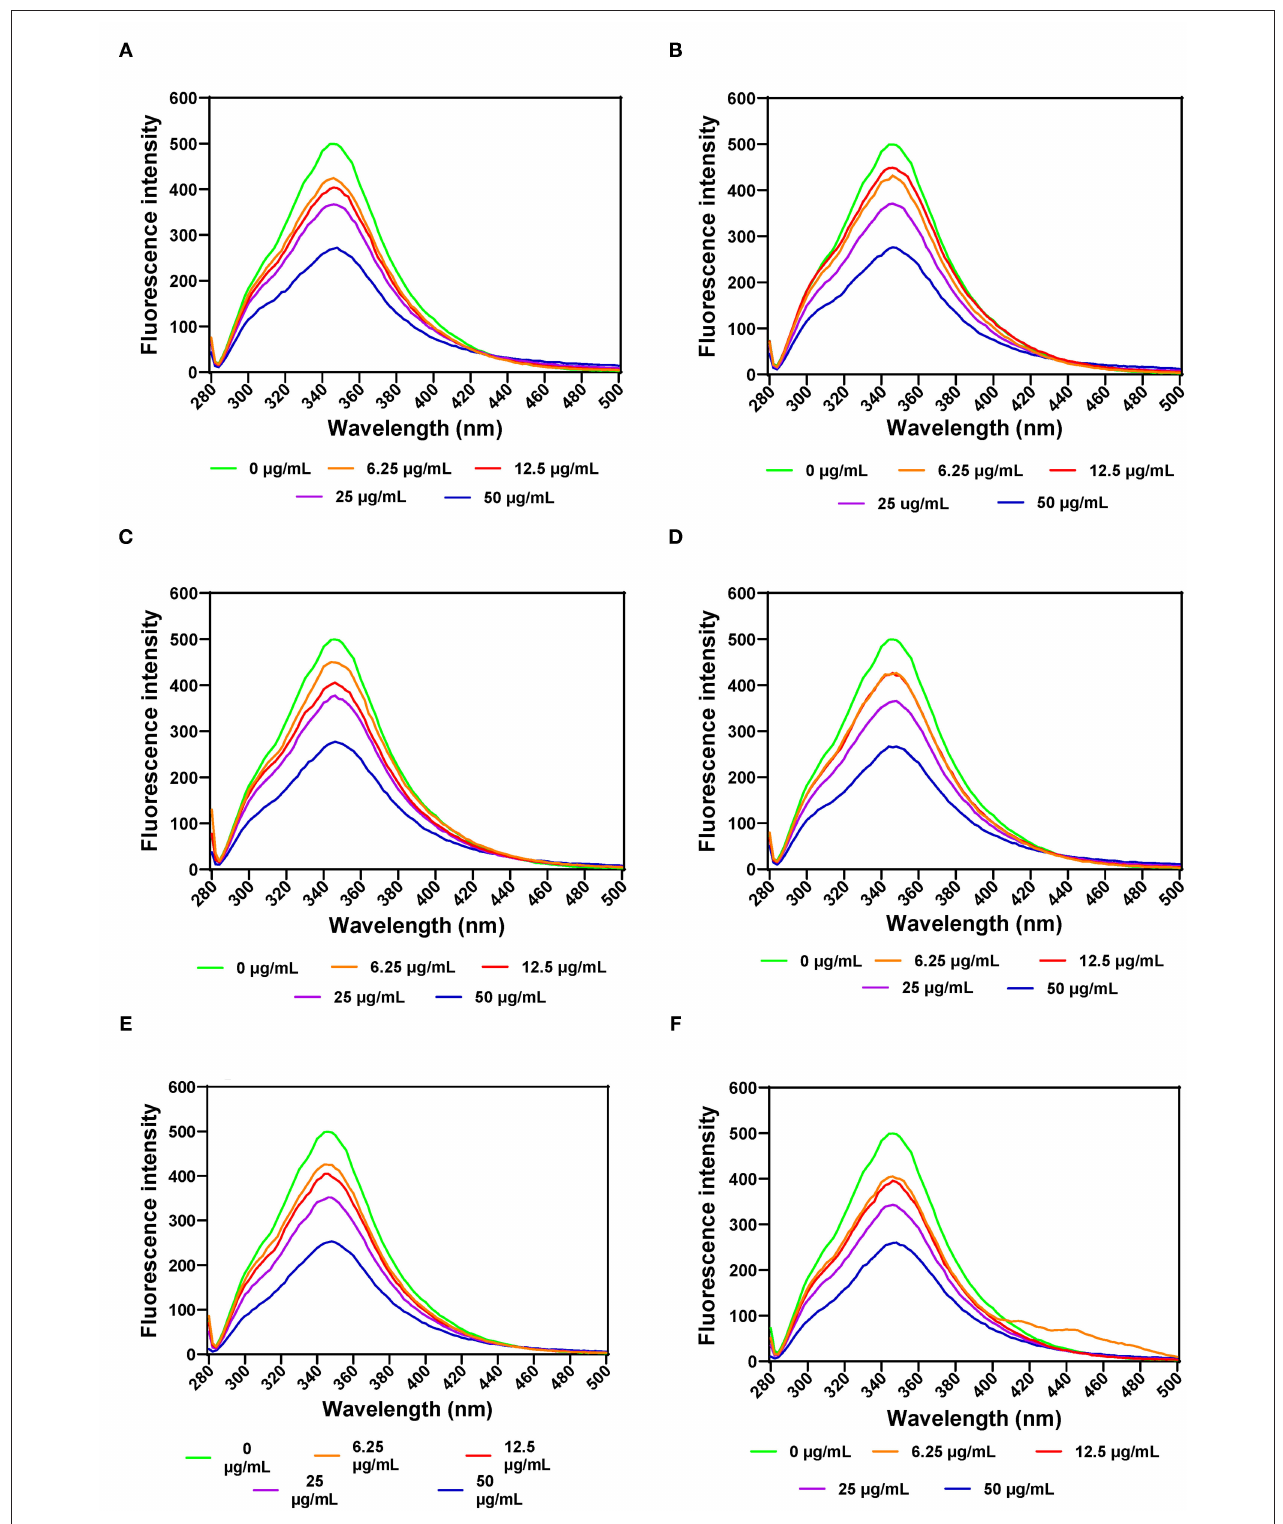
FIGURE 4 | Intrinsic fluorescent intensity of pancreatic lipase in the presence of varied concentrations of leaf extracts from: (A) AV-40-T1, (B) AV-40-T2, (C) SM-40-T1, (D) SM-40-T2, (E) TO-40-T1, and (F) TO-40-T2. Plants were produced with nitrogen fertilizer (40 kg N/ha), which was applied at (T1) or after (T2) planting.